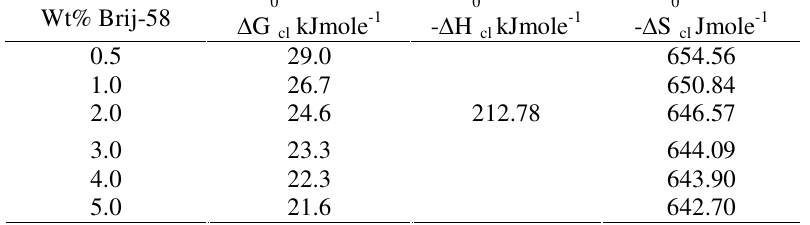
Table 6. Thermodynamic parameter CP of